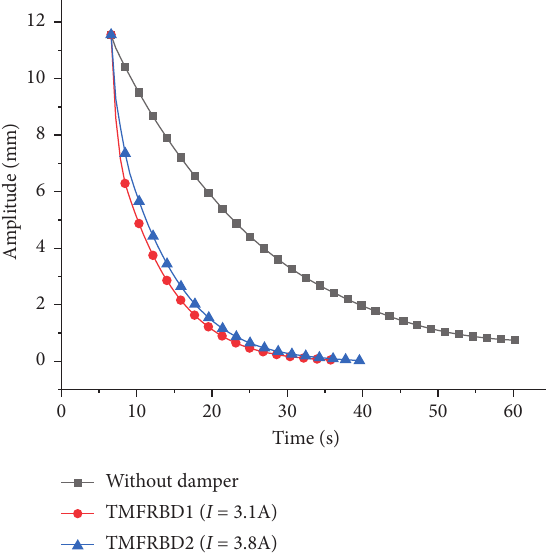
Figure 12: The amplitude attenuation curve under